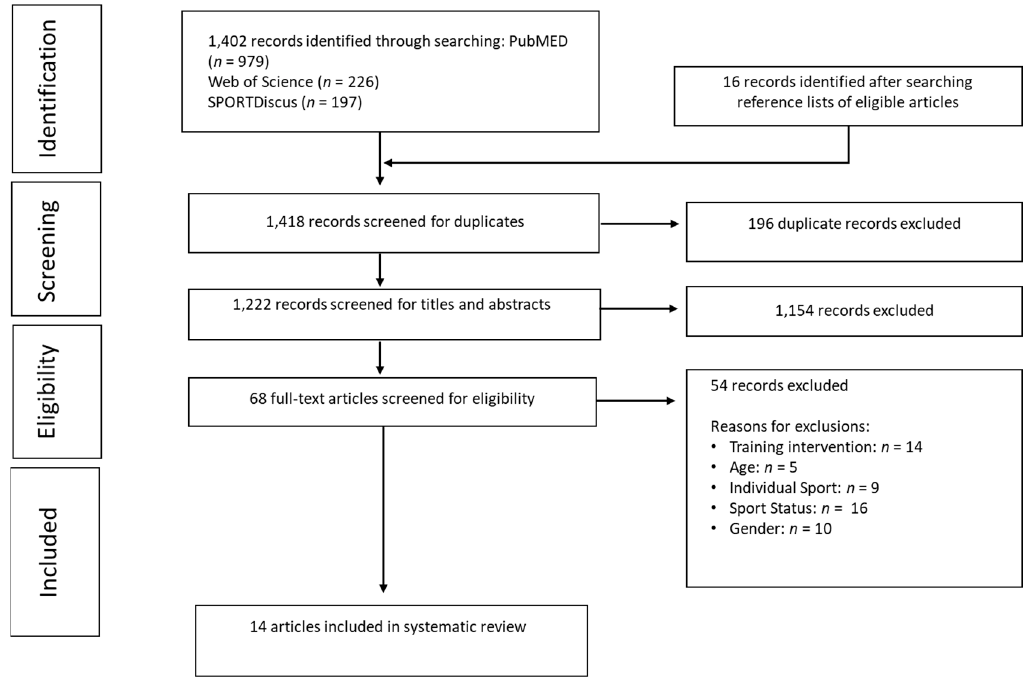
Figure 1. Flow chart of the literature search process using the Preferred Reporting Items for Systematic Reviews and Meta-Analyses (PRISMA) guidelines.